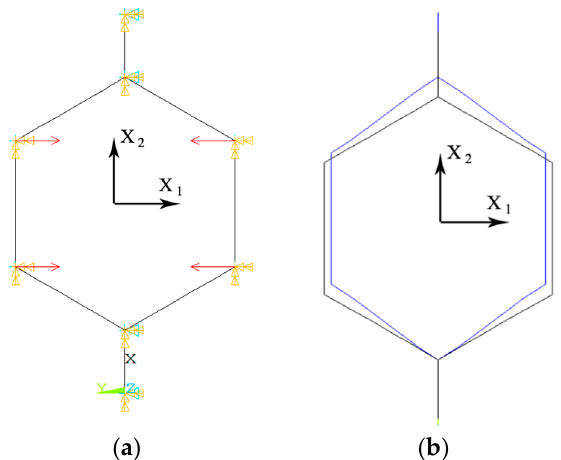
Figure 8. ( a ) The geometry, loads, and boundary conditions used in the 2D hexagonal honeycomb finite element (FE) model; and ( b ) its deformed shape, for (cid:2026) (cid:2869) (cid:3405) 0 and (cid:2026) (cid:2870) = 0